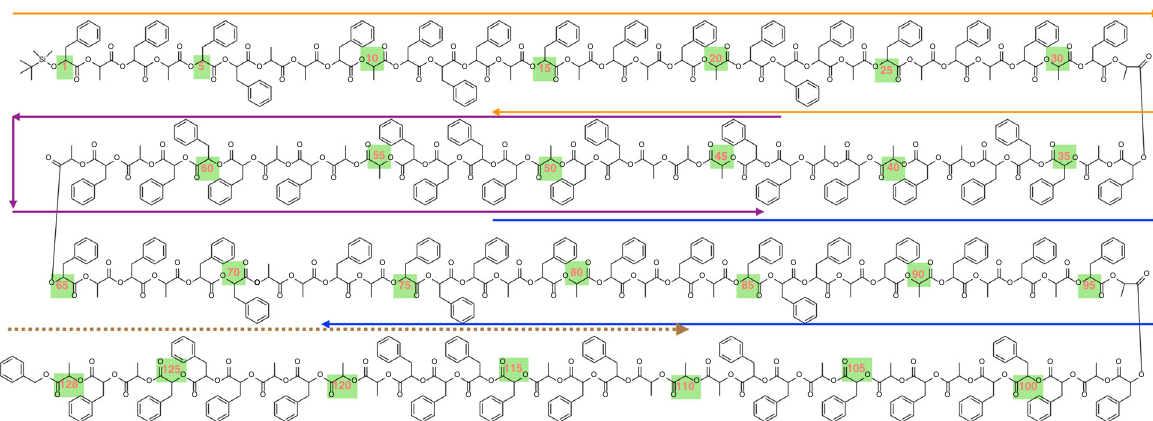
Hydroxyphenylazo)benzoic acid (HABA) or trans -2-[3-(4- tert -Butylphenyl)-2- methyl-2-propenylidene]malononitrile (DCTB) was used as a matrix. A polymer sample and matrix were dissolved in THF at 5mgmL − 1 and 30mgmL − 1 , respec- tively, and, these solutions were mixed in 1:1 to 1:5 ratio depending on the molecular weight of the analyte. 0.8 μ L of the mixed solution was spotted on a MALDI plate, and dried in the air. PcLs were fragmented into a i fragment containing the original alpha group (TBDMS) and a new carboxylic acid terminus and y i fragment having the original omega group (benzyl ester) and a new alkene terminus via 1,5-H rearrangement. For sequencing, the mass difference between adjacent fragments (72Da for L residue and 148Da for P residue) was used. fragment that contains the original alpha group and a new carboxylic acid